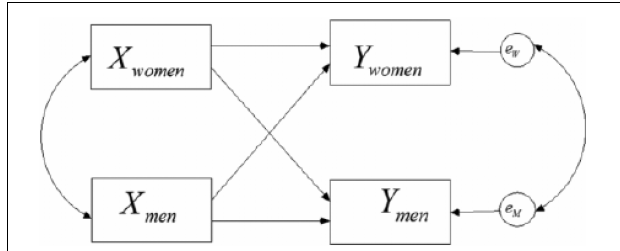
FIGURE 1 | The Actor-Partner Interdependence Model (APIM). X represents one’ perception of dyadic coping (i.e., one of the dyadic coping subscales), while Y represents parenting stress (PIP), depression, anxiety and stress (DASS) or marital and sexual adjustment (MMQ subscales). For supportive and negative dyadic coping: an actor effect for women (men) can be interpreted as the effect of female (male) perception of her (his) partner’s supportive/negative coping efforts on the female (male) adjustment; a partner effect of women in men (of men in women) can be interpreted as the effect of female (male) perception of her (his) partner’s supportive/negative coping efforts on the partner’s adjustment. For common dyadic coping: an actor effect for women (men) can be interpreted as the effect of female (male) perception of the couple’s common coping efforts on the female (male) adjustment; a partner effect of women in men (of men in women) can be interpreted as the effect of female (male) perception of the couple’s common coping efforts on the partner’s